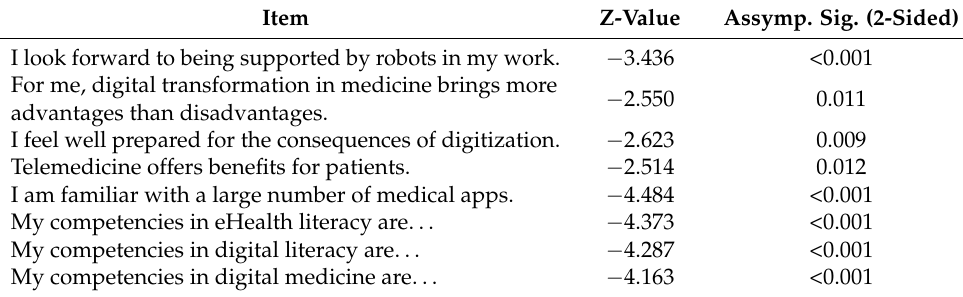
Table 3. The mean values for the self-assessment of the subcompetencies at T1 and T2 according to German school grade format (i.e., from 1 = very good to 6 = insufficient). Mean T1 Mean T2 Item (Two Decimal Places) (Two Decimal Places) My competencies in eHealth literacy are. . . 4.13 (SD = 1.32; N = 200) 3.17 (SD = 1.14; N = 128) My competencies in digital literacy are. . . 3.98 (SD = 1.36; N = 198) 3.05 (SD = 1.10; N = 129) My competencies in digital medicine are. . . SD = standard deviation Table 4. The results of the Wilcoxon signed-rank test on the pseudonymized pairs at T2. Item Z-Value Assymp. Sig. (2-Sided) − 3.436 <0.001